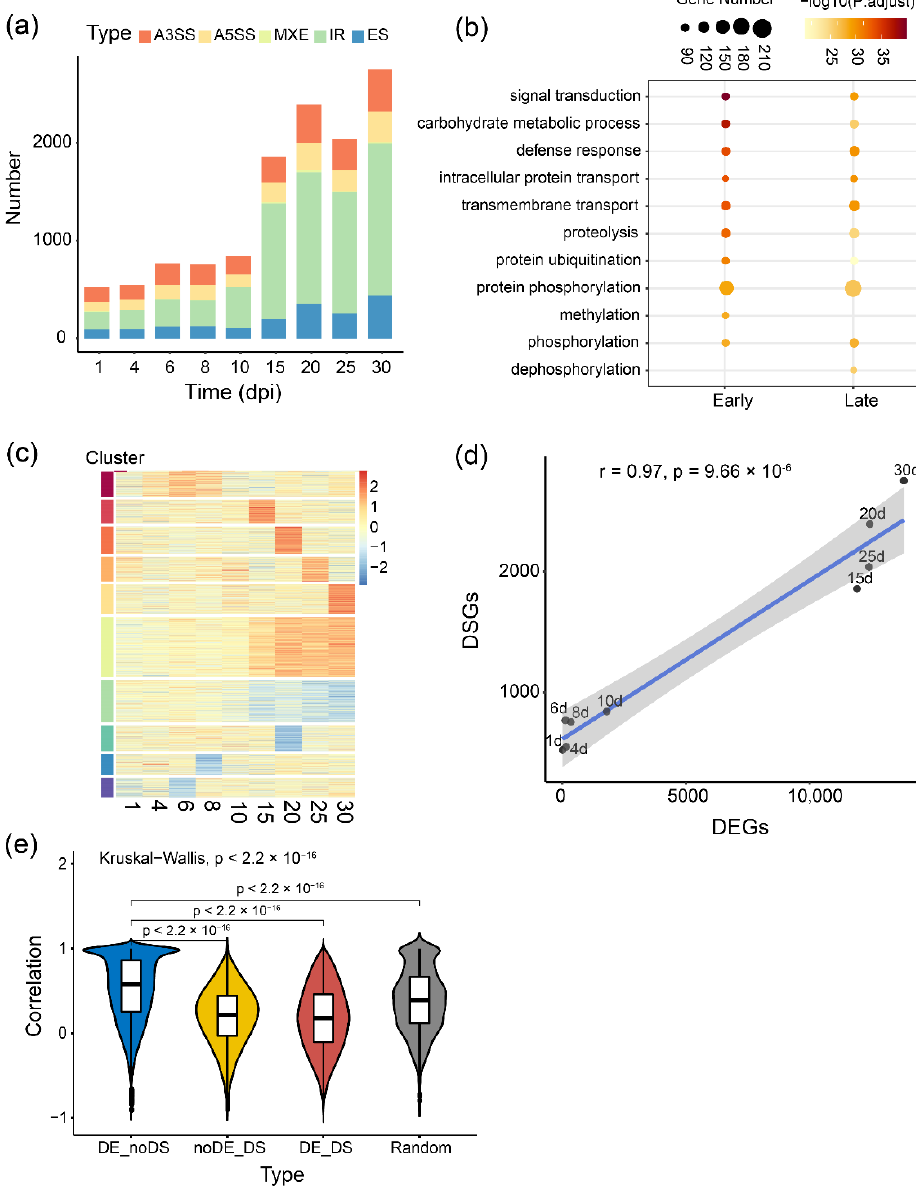
Figure 2. Genome-wide analysis of alternative splicing dynamics during nodule development. ( a ) Number of differentially splicing events at each time point. Different colors represent five types of common AS events. IR: Intron retention, A3SS: Alternative 3′ splicing site, A5SS: Alternative 5′ splicing site, ES: Exon skipping, MXE: Mutually exclusive exons. dpi: day post-inoculation; ( b ) GO enrichment analysis of the differentially spliced genes at early stage (Early, 1 to 10 dpi) and late stage (Late, 15 to 30 dpi); ( c ) Heatmap of the global alternative splicing changes measured by ∆ PSI between inoculated and uninoculated groups over time courses. Red represents higher PSI under inoculated conditions, and blue represents the lower. ∆ PSI: The difference of percent spliced in; ( d ) The number of the differentially spliced genes (DSGs) versus the differentially expressed genes (DEGs) at 9 time points. Pearson correlation coefficient (PCC) was performed, p -value = 9.66 × 10 − 6 ; ( e ) Spearman correlation coefficient (SCC) of the expression between transcripts and their corresponding genes. 16,301 DE but not DS genes (DE_noDS, N = 71,604, r = 0.52), 630 DS but not DE genes (noDE_DS, N = 20,503, r = 0.20), 1888 DS and DE genes (DE_DS, N = 77,884, r = 0.17) and 1000 random selected genes (Random, N = 4976, median SCC = 0.39). Kruskal–Wallis test was used, p < 2.2 × 10 − 16 . N showed the number of genes-transcripts pairs for correlation